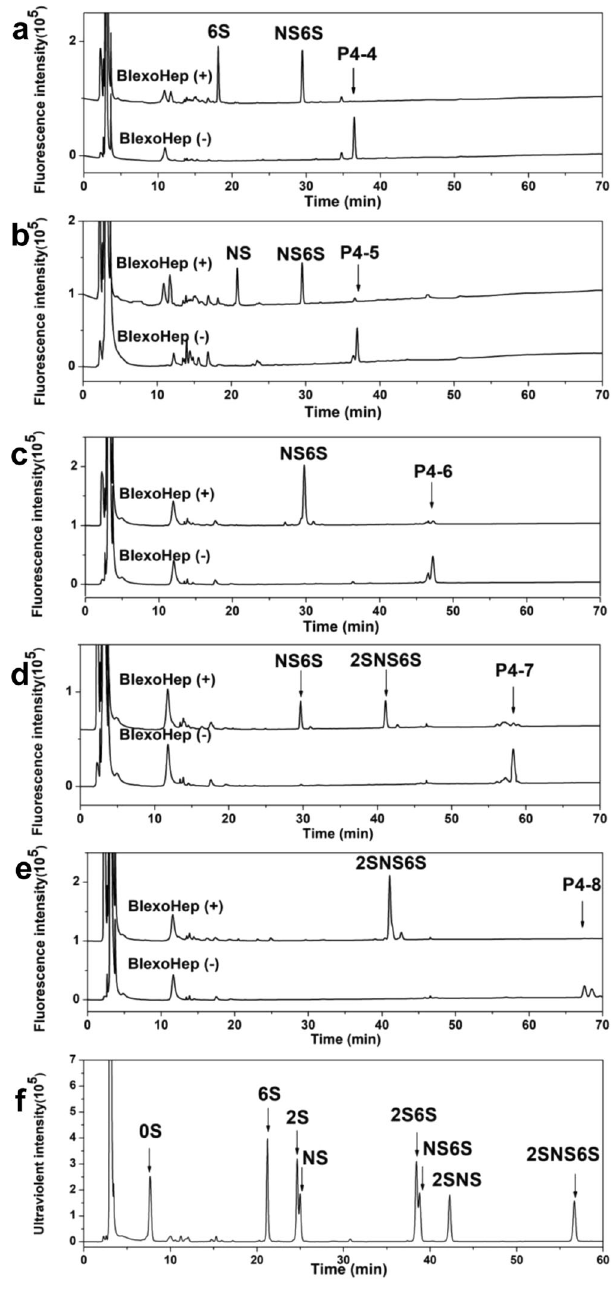
Fig. 2 Substrate speci fi city of BIexoHep. Structure-de fi ned HP tetrasaccharides P4-4 ( a ), P4-5 ( b ), P4-6 ( c ), P4-7 ( d ), and P4-8 ( e ) were individually digested with BIexoHep, and the digests were labeled with 2-AB followed by analysis using anion-exchange HPLC on a Pack Polyamine II column eluted using a NaH 2 PO 4 gradient (0 – 1 M) and monitored using a fl uorescence detector with excitation and emission wavelengths of 330 and 420 nm, respectively. The types of disaccharides were determined by comparing their elution positions with those of authentic 2-AB-derivatized unsaturated HP/HS disaccharides indicated by arrows in ( f ). 0S, Δ UA(1-4) GlcNAc; 6S, Δ UA(1-4)GlcNAc6S; 2S, Δ UA2S(1-4)GlcNAc; NS, Δ UA(1-4) GlcNS; 2S6S, Δ UA2S(1-4)GlcNAc6S; NS6S, Δ UA(1-4)GlcNS6S; 2SNS, Δ UA2S(1-4)GlcNS; 2SNS6S, Δ